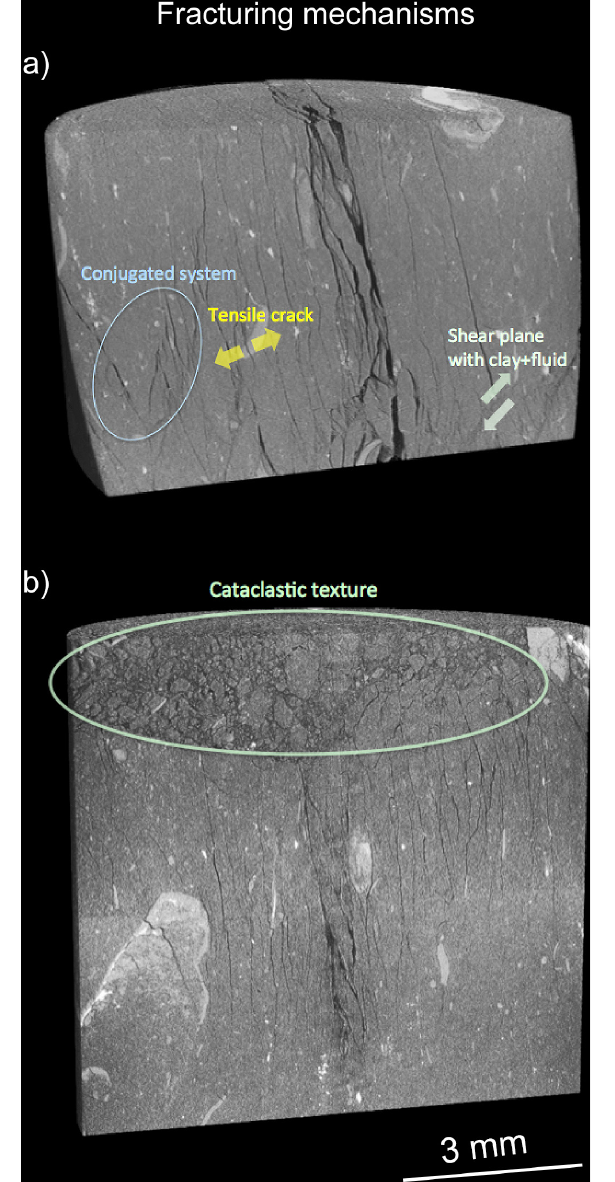
FIGURE 3 | Subsections of the sample at the latter stages of the experiment, where the mechanical deformation of the sample was more pronounced: different fracturing mechanisms are highlighted in the figures (see text for complete details). (a) middle section of the sample, (b) top section of the sample.